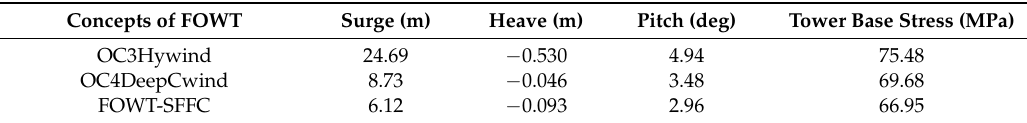
Table 8. Foundation motions and tower base stress under steady wind speed of 11.4 m/s.